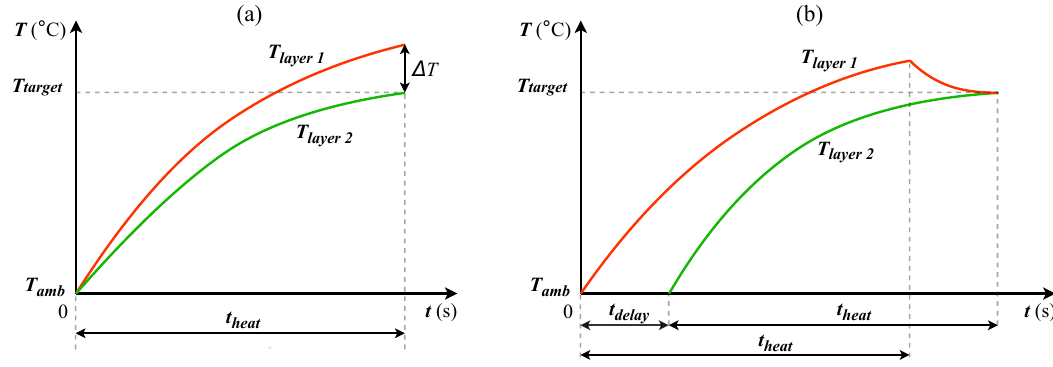
Figure 3. ( a ) Temperature imbalance between layers at the end of the conventional internal heating process. ( b ) Concept of temperature balancing by using the proposed heating schedule